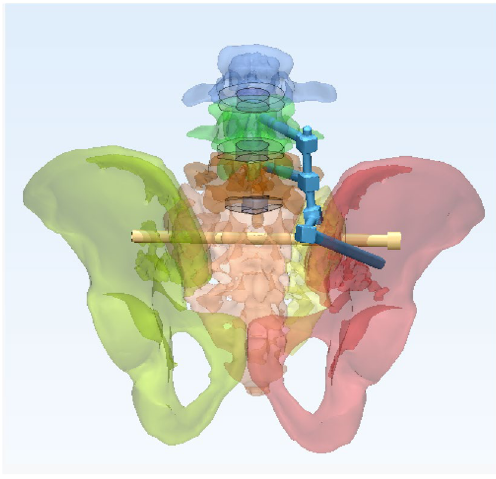
Figure 5. Sketch map of L4L5LS1 (created by Mimics17.0 https:// www. mater ialise. com/ en/ healt hcare/ elect ronic- instr uctio ns- for- use/ mimics- resea rch).